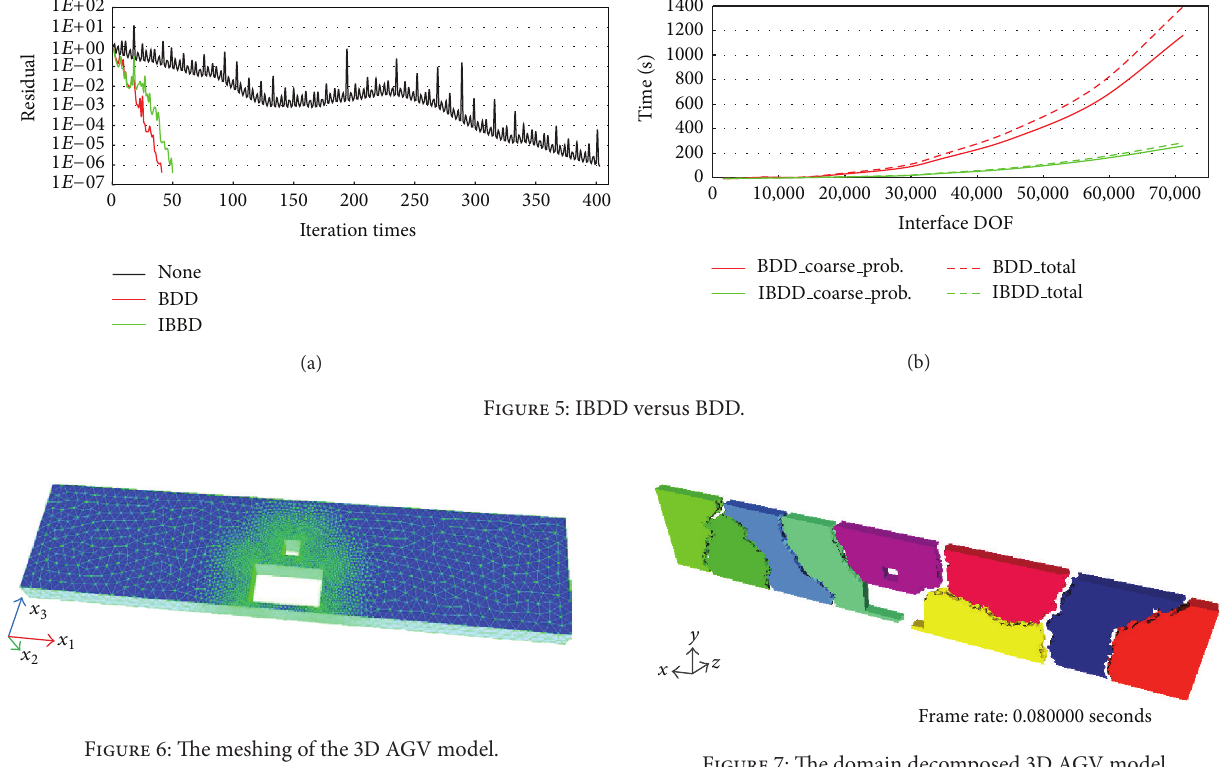
Figure 7: The domain decomposed 3D AGV